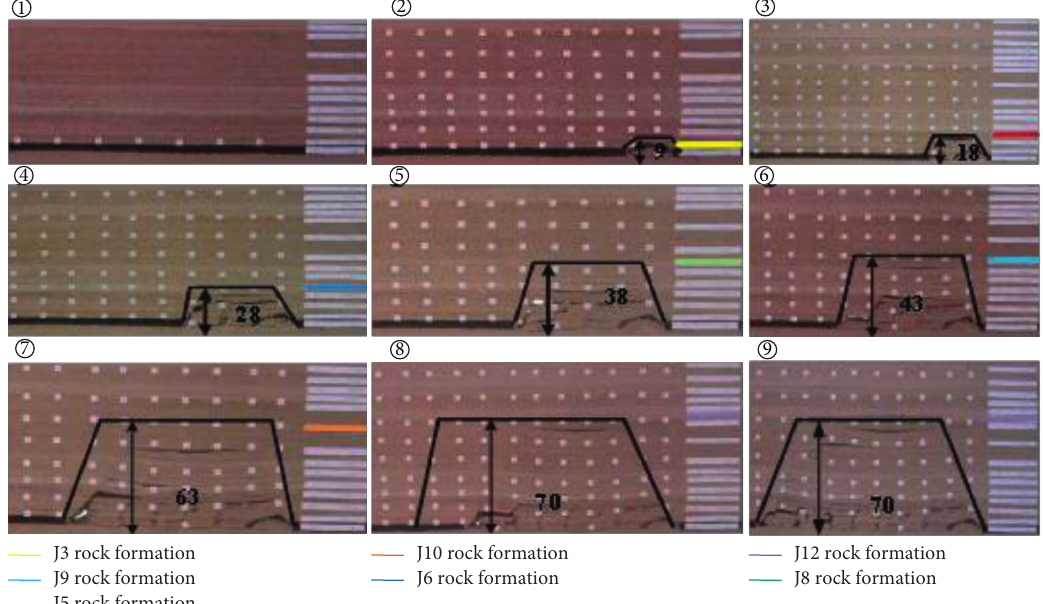
Figure 11: Development height of water conducting fracture zone of scheme